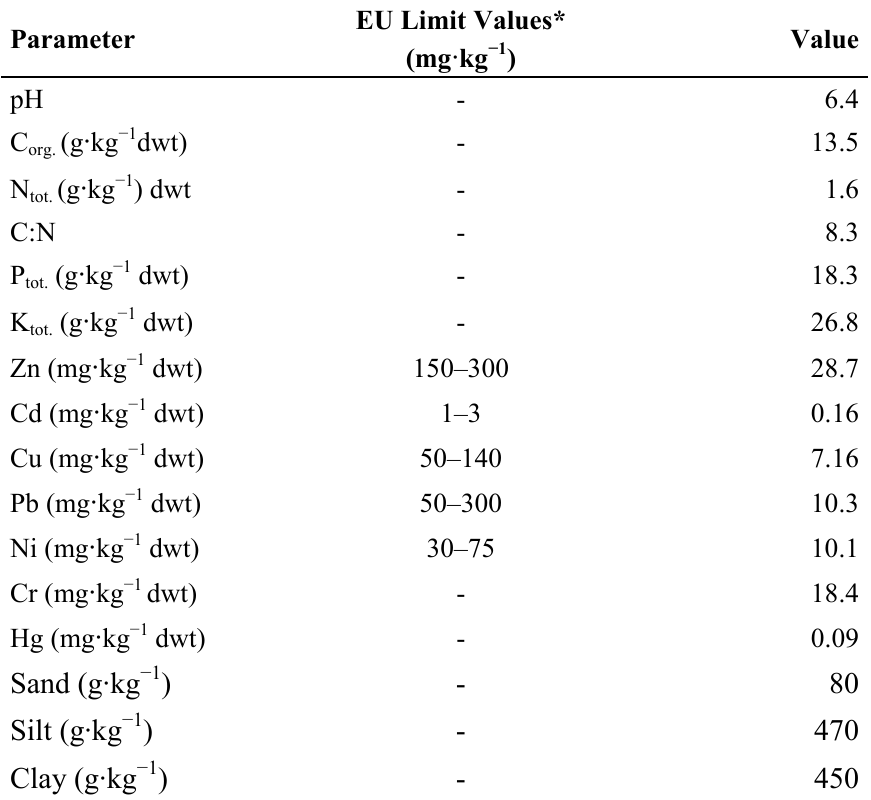
Table 1. Characteristics of the soil used in the